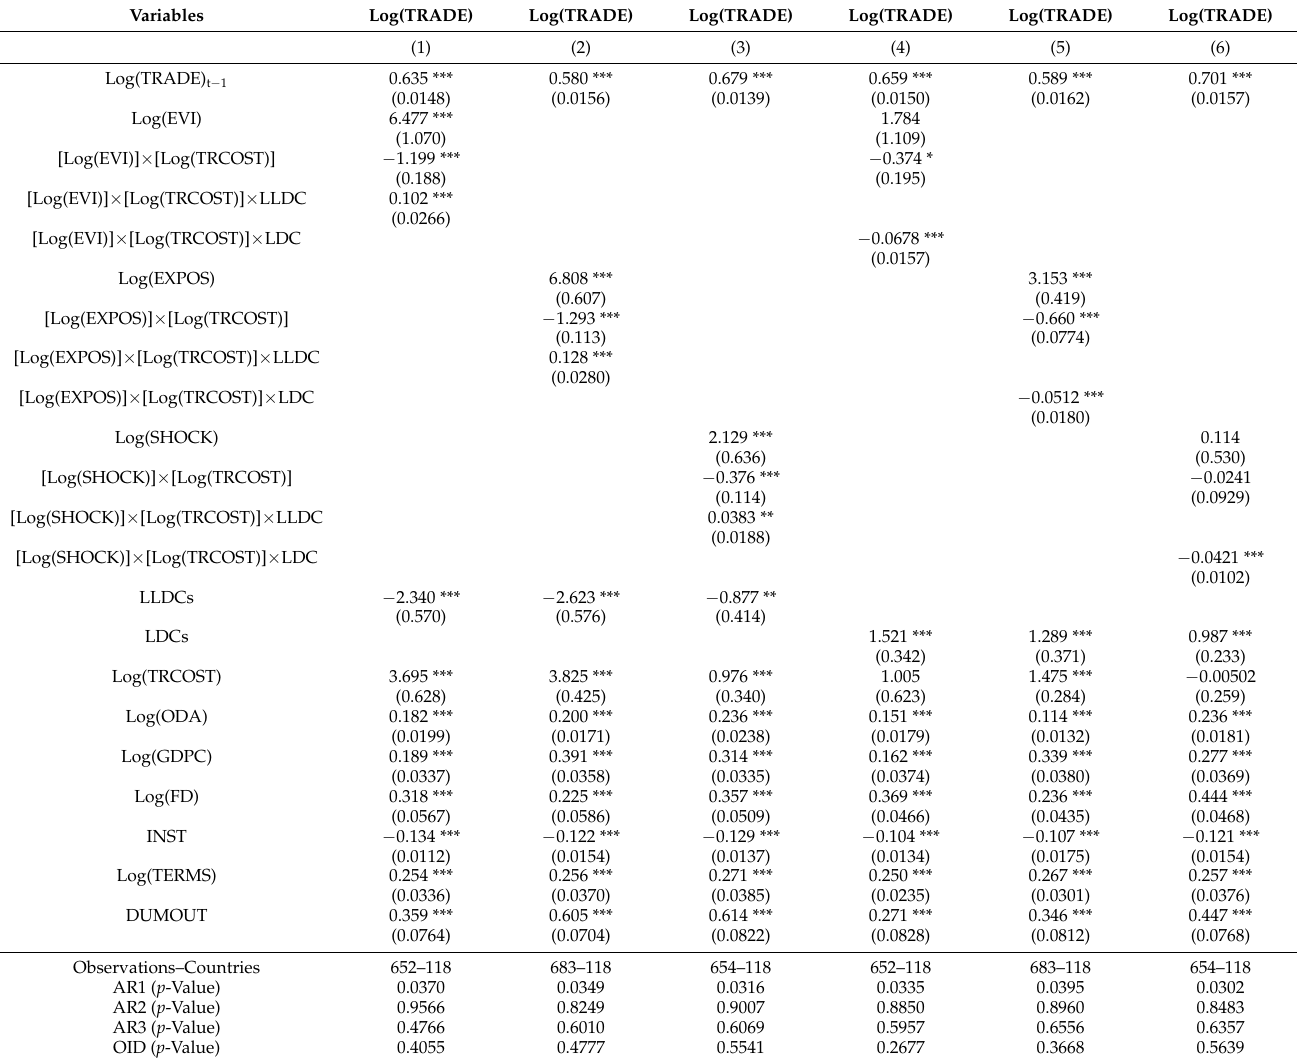
Table 6. Joint effect of EVI and trade costs on the participation in international trade in LDCs and LLDCs. Estimator : Two-step system